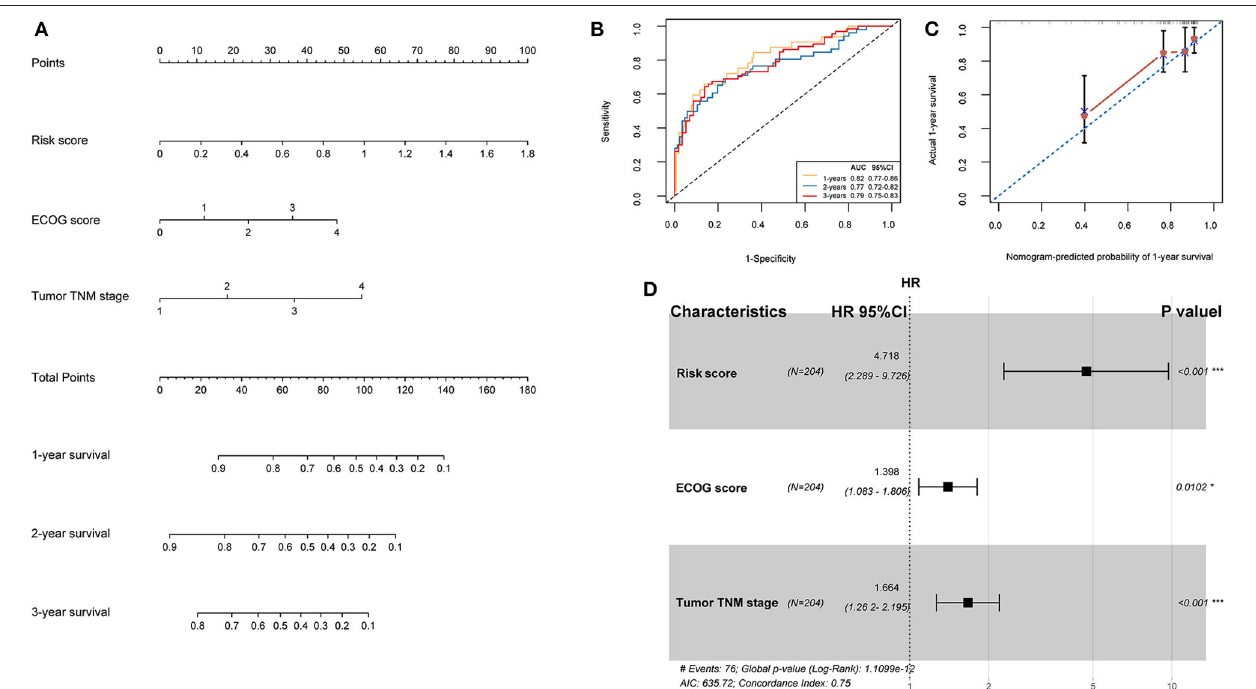
FIGURE 10 | (A) Nomogram predicting the OS in HCC patients containing the risk score. (B) ROC curves and AUC for 1-, 2, and 3-year survival of the nomogram. (C) Calibration curve of 1-year survival in the nomogram and ideal model. (D) Forest plot of risk factors affecting the survival in HCC patients.